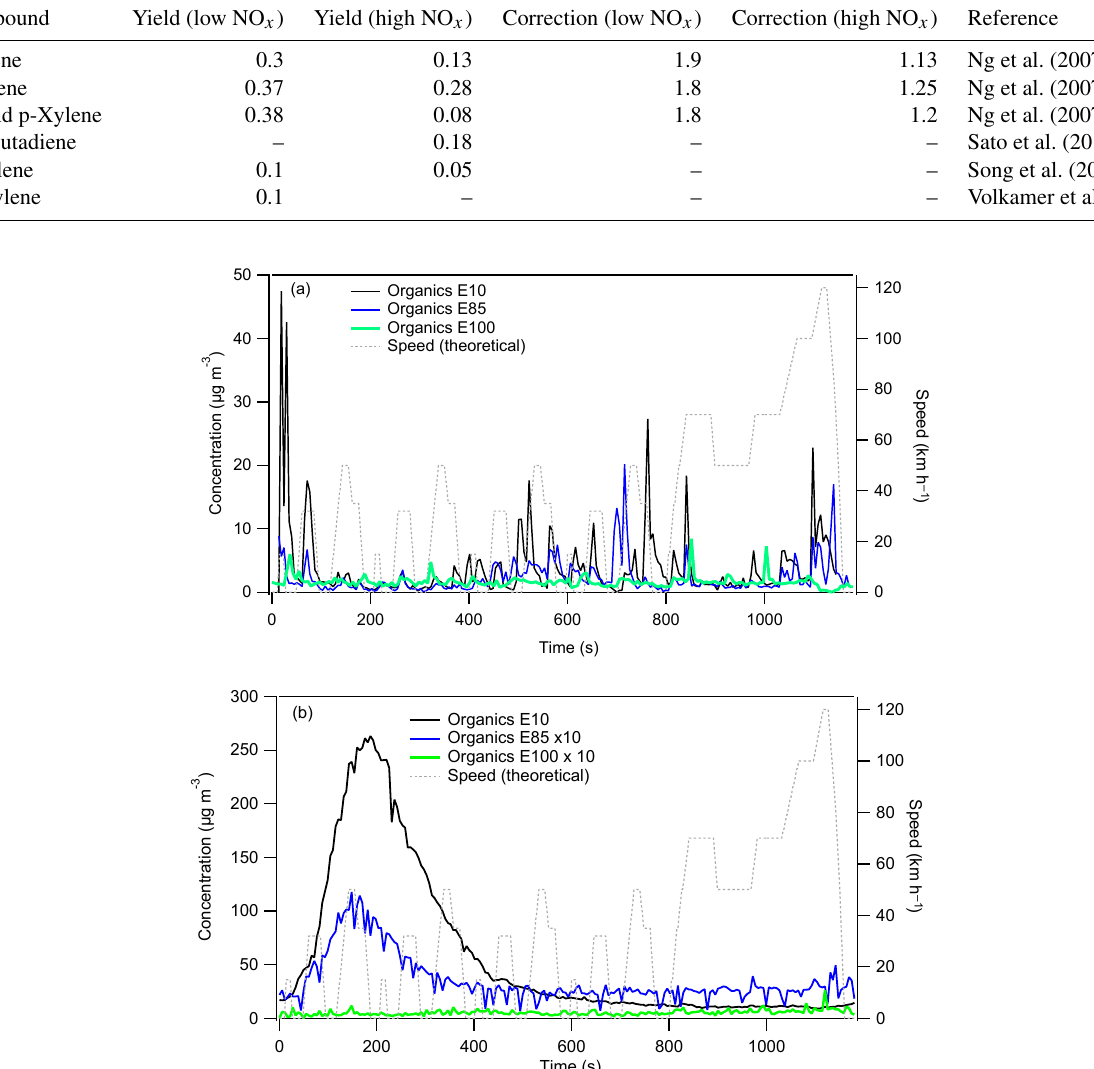
Table 4. The SOA yields for the different VOCs. The vapour wall-loss correction factors are obtained from Zhang et al. (2014). Compound Yield (low NO x ) Yield (high NO x ) Correction (low NO x ) Correction (high NO x ) Reference Toluene 0.3 0.13 Benzene 0.37 Acetylene 0.1 – – – Volkamer et al. (2009)